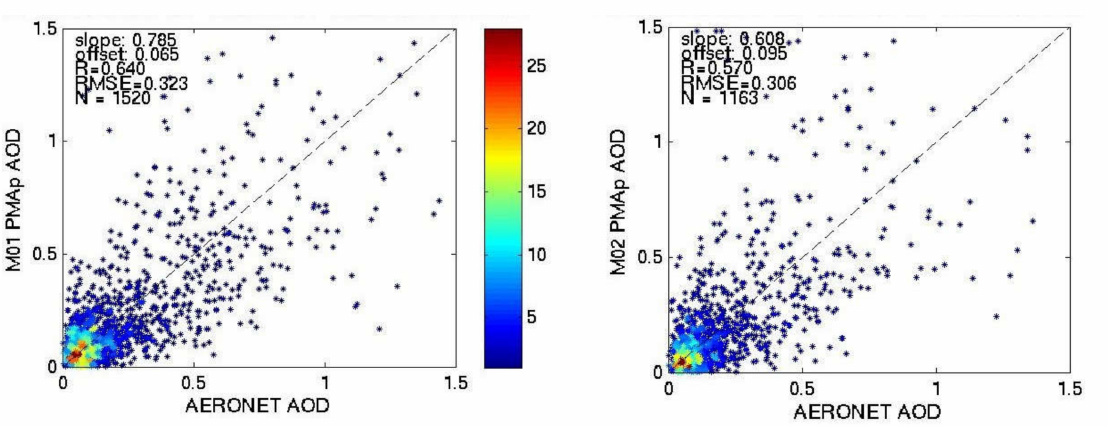
Figure 8. Scatter plot of the measurements for the validation period in 2015 for land sites: AOD at 550 nm from PMAp/Metop-B (left panel) and -A (right panel) is plotted versus the corresponding AERONET AOD measurements. The color illustrates the density of the measurements.